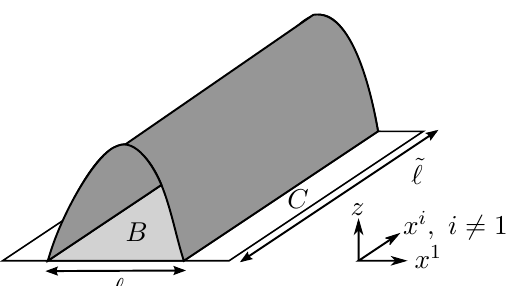
Figure 8. Holographic minimal surface calculation of the entanglement entropy. B is the entangling region and C is its